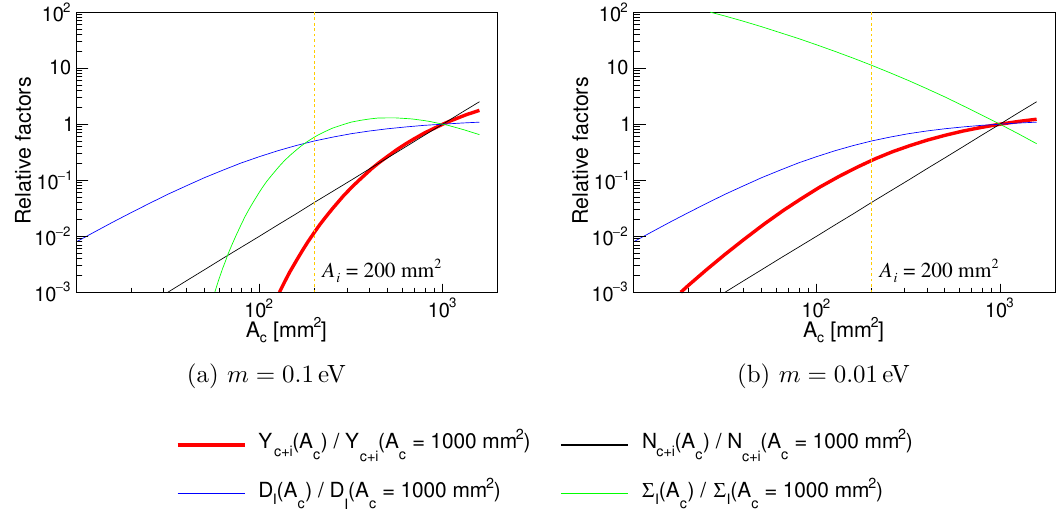
Figure 4 . Behavior of individual factors in eq. (2.10) as a function of creation beam cross sections A c with respect to a fixed inducing beam cross section A i = 200 mm 2 (yellow dashed line) obtained by assuming an ALP mass of (a) m = 0 . 1 eV and (b) m = 0 . 01 eV . The red, black, blue, and green curves indicate Y c + i , N c + i ≡ 1 N 2 N i , D I , and Σ I , normalized by their values at A c = 1000 mm 2 c 4